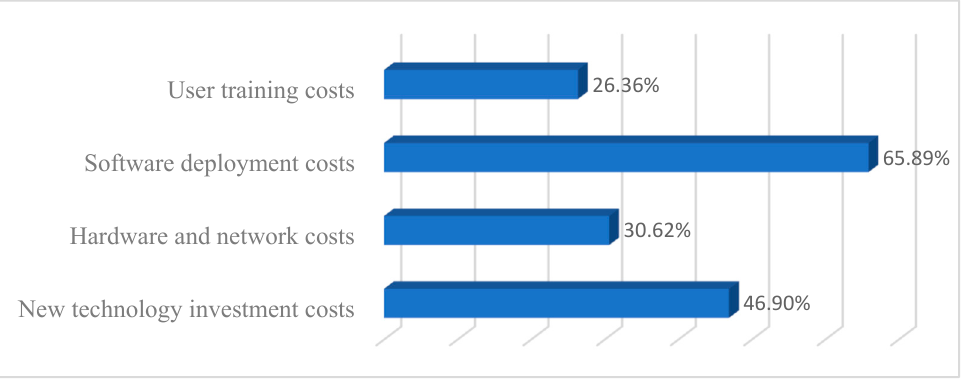
Figure 8. Investment costs of digital transformation.